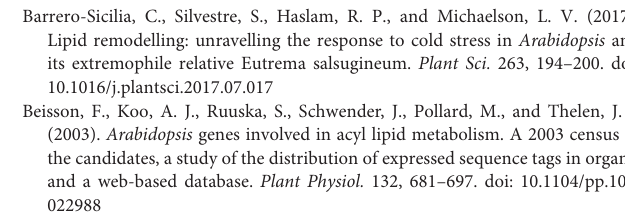
Supplementary Figure 1 | Quality inspection of maize seedling root transcriptome data under low temperature stress. Supplementary Figure 2 | Functional annotation of genes related to lipid metabolism in maize roots under low temperature stress. Supplementary Figure 3 | Verification of differentially expressed genes in maize seedling roots under low temperature stress by qRT-PCR. Supplementary Figure 4 | Enrichment of transcription factors of genes related to lipid metabolism in maize roots under low temperature stress. Supplementary Figure 5 | Co-expression analysis of transcription factors and lipid-related genes. Supplementary Table 1 | Related genes qRT-PCR verification primers. Supplementary Table 2 | Expression of lipid-related genes under cold